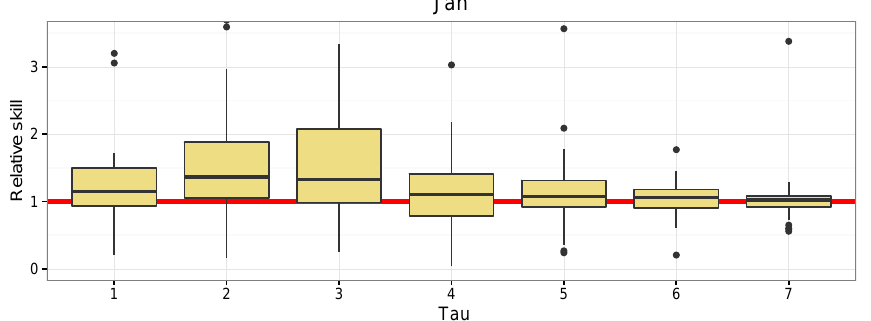
Figure 9. Box plots of relative skill (RS), as defined by Eq. (32), for January, and τ = 1 ,..., 7. The vertical axis is truncated at 3.5, leaving 14 RS values not shown. Values above 1 indicate that ˆ p v gives better forecasts than ˆ p z .